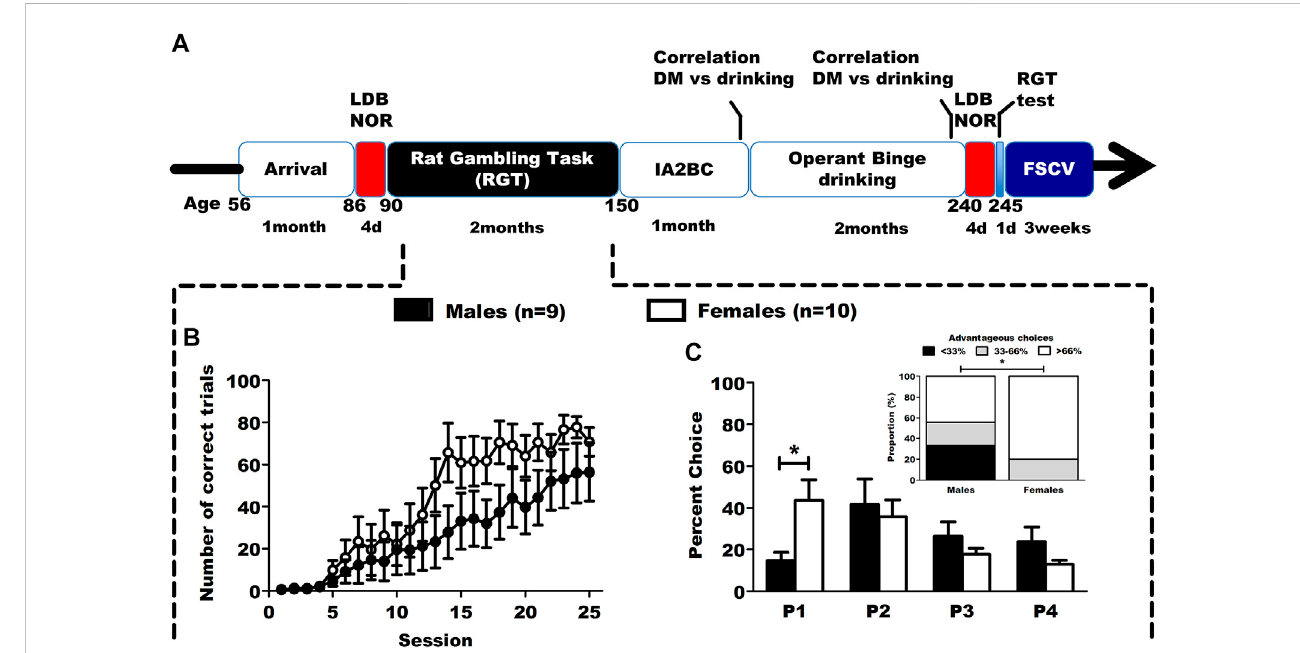
FIGURE 1 Timeline of the study and baseline results in the RGT. (A) Timeline of the longitudinal study. Animals were tested in DM capacities, anxiety (LDB) and learning (NOR) both before and after an operant binge drinking procedure. At the end of the behavioral experiments, the animals (as well as a control group without behavioral training) were sacri fi ced to assess mesolimbic phasic dopamine transmission in the core of the NAc, using ex vivo FSCV. (B) Correct trials during the fi rst phase of RGT training. Results are expressed as mean ± SEM of the proportion of correct trials over the total number of trials during training sessions. (C) Choice behavior in the baseline session of RGT, and distribution of the DM level in categories (poor < 33%, neutral 33% – 66% and good > 66%).ThemaleratsfavoredtheoptimalP2option,whilethefemaleratsfavoredbothP1andP2.Themalegrouphadsigni fi cantlymoreindividualswithapoor DM level than the female group. Results are expressed as mean ± SEM of the percent choice for each option, and as number of rats in each categories of decision makers. # p < 0.01, * p <